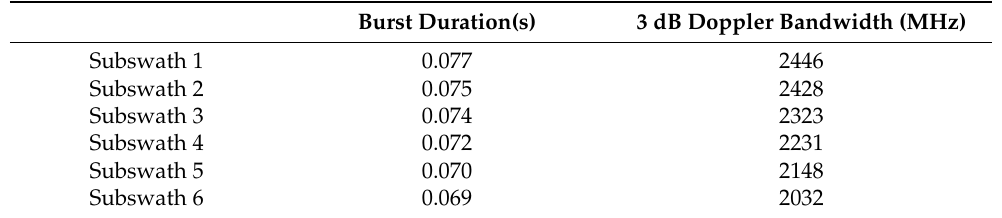
Table 4. Scanning parameters of Sat-1.